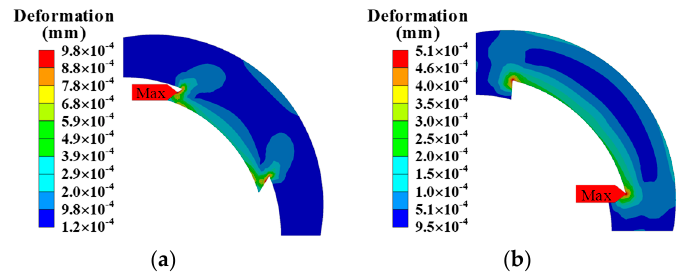
Figure 16. Distribution of PM stress with SIPM2. ( a ) Radial stress. ( b ) Tangential stress. ( c ) Equivalent stress.